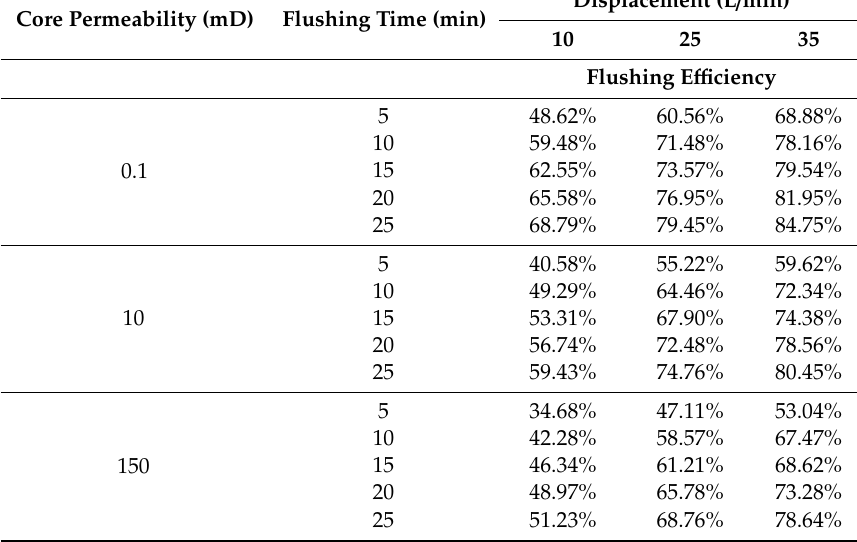
Table 2. Results of flushing e ffi ciency under di ff erent flushing displacement and